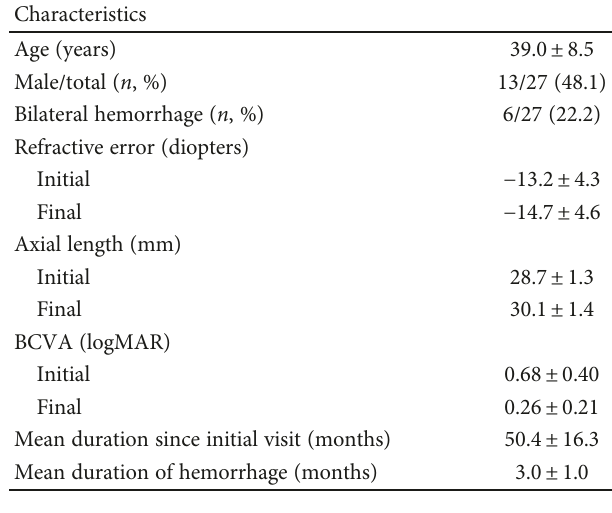
Figure 2: Distribution of the initial and fi nal Snellen BCVA in this study. Table 2: Comparison of clinical characteristics between group 1 and group